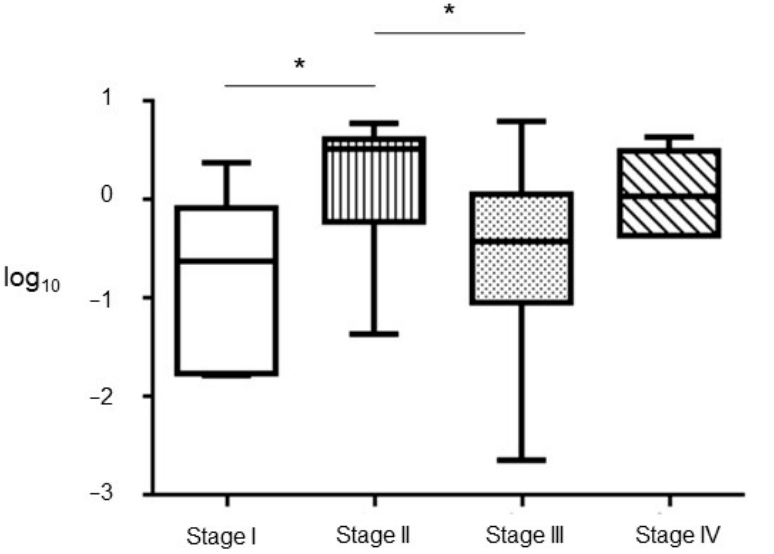
Figure 6. ∆ Np73 mRNA contained in the EVs according to tumoral stage. Box and whisker plot displaying the qPCR data related to the EVs’ concentration. Statistical significance, * p < 0.05.